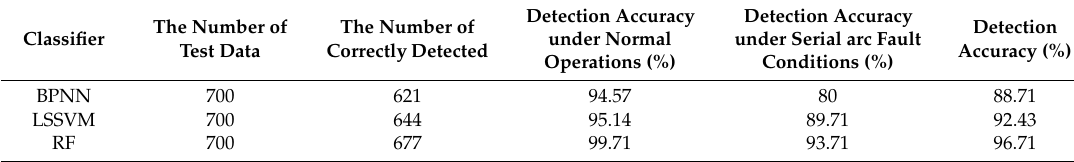
Table 5. The detection result of the di ff erent